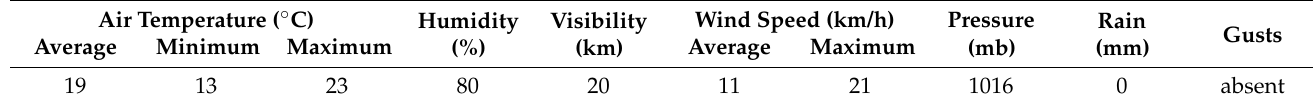
Table 2. Input data of weather